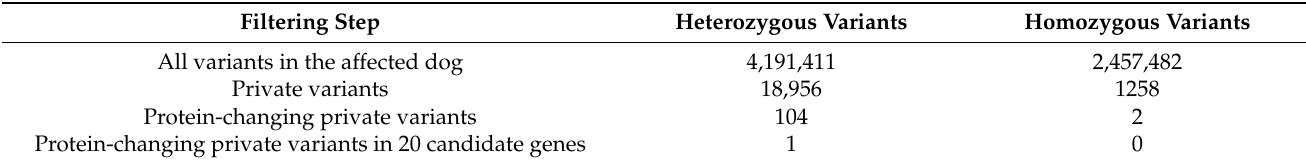
Table 2. Results of variant filtering in the affected dog against 792 control genomes.